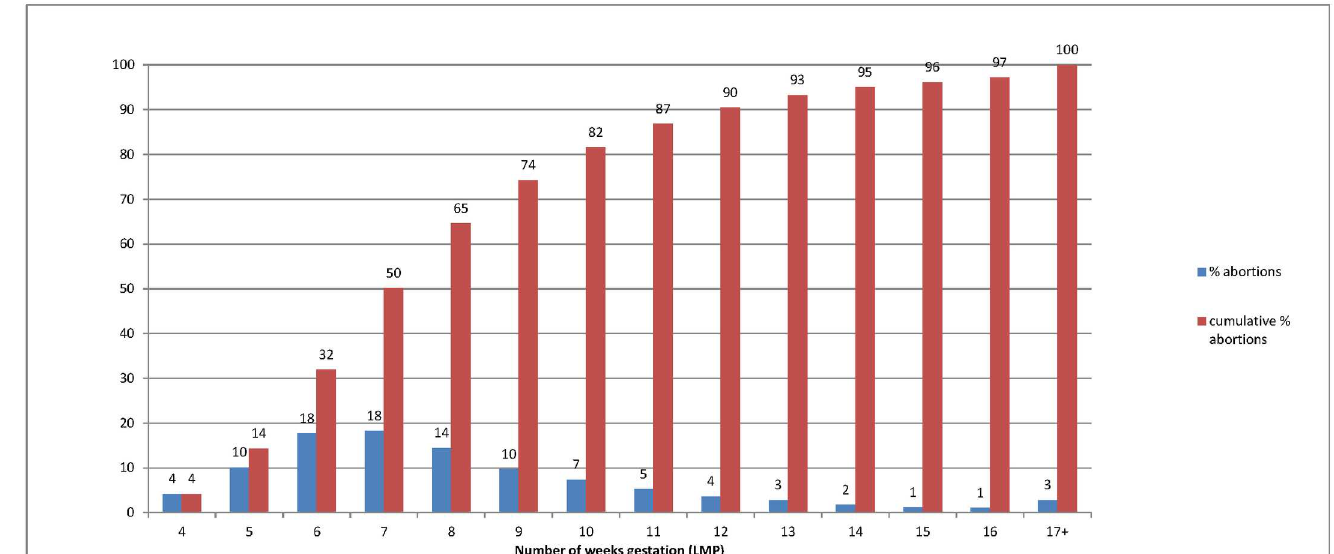
Fig 1. Percentage of abortions by weeks gestation (LMP) and cumulative percentage of abortions by gestation.